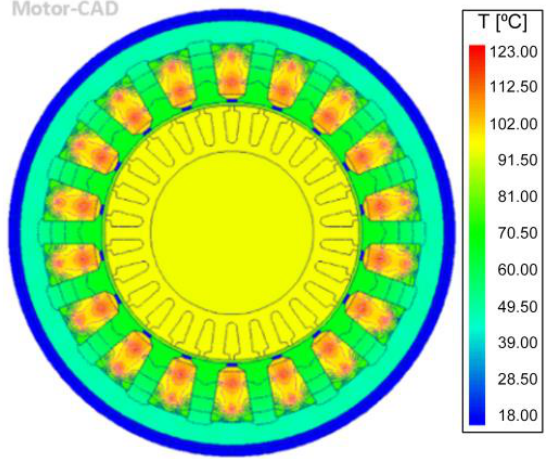
Figure 12. Radial view of water-cooled motor after FEM analysis.